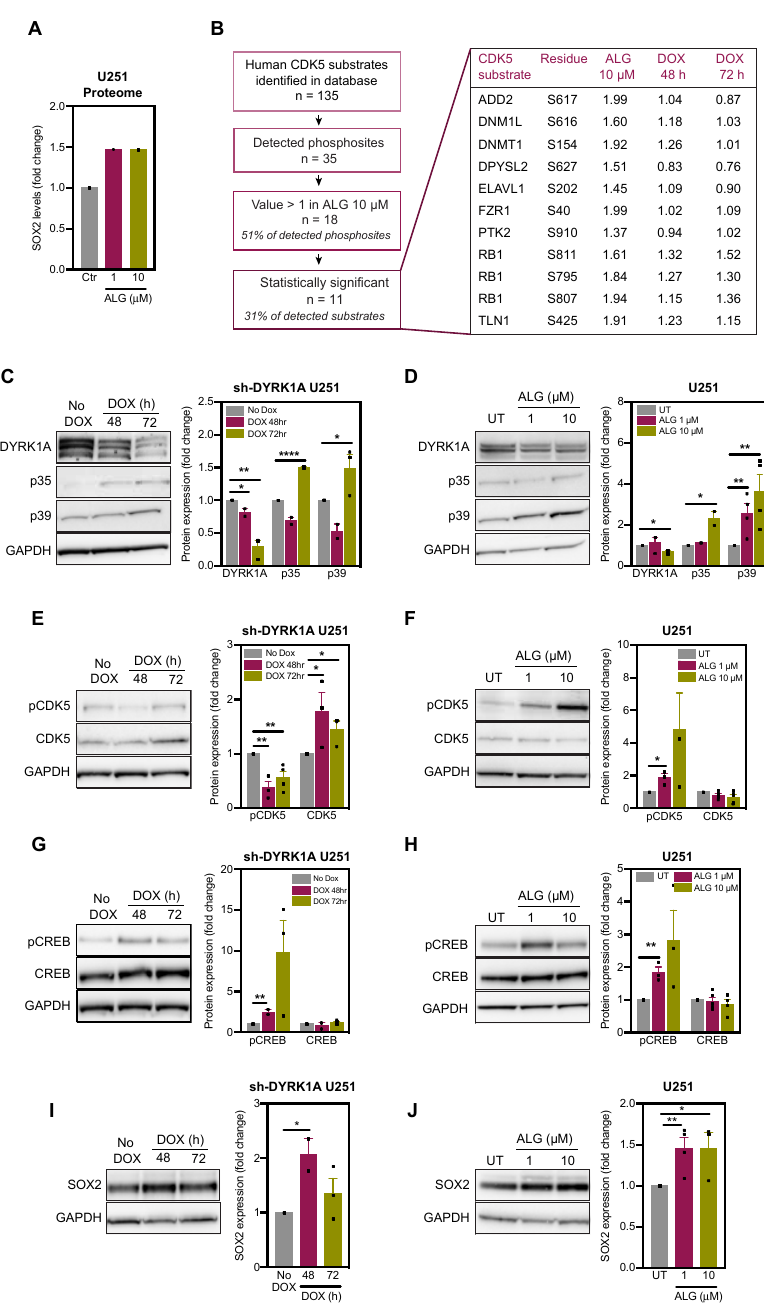
Figure 3. DYRK1A inhibition activates CDK5 pathway in U251 glioblastoma cells. ( A ) SOX2 expression in U251 cells treated with the DYRK1A inhibitor ALGERNON (ALG) for 72 h. Control (Ctrl) cells were left untreated. Data extracted from proteomic analysis in reference [17]. ( B ) Annotation of CDK5 substrates (derived from PhosphoSitePlus) in the phosphoproteome of U251 cells treated with ALG (72 h), and U251 cells transfected with doxycycline (DOX)-inducible shRNA targeting DYRK1A (U251 sh-DYRK1A) treated with DOX. ( C , D ) Immunoblot images and quantification of DYRK1A, p35 and p39 in U251 sh-DYRK1A cells treated with DOX and U251 cells treated with ALG (72 h)( n = 2–4). ( E , F ) Immunoblot images and quantification of phosphorylated (p-CDK5) and total CDK5 in U251 sh-DYRK1A cells treated with DOX and U251 cells treated with ALG (72 h)( n = 2–4). ( G , H ) Immunoblot images and quantification of phosphorylated (p- CREB) and total CREB in U251 sh-DYRK1A cells treated with DOX and U251 cells treated with ALG (72 h)( n = 2–4). ( I , J ) Immunoblot images and quantification of SOX2 in U251 sh-DYRK1A cells treated with DOX and U251 cells treated with ALG (72 h)( n = 2–4). All bar graphs represent mean ± SEM (two-tailed, unpaired t-test, * p < 0.05, ** p < 0.01, **** p <